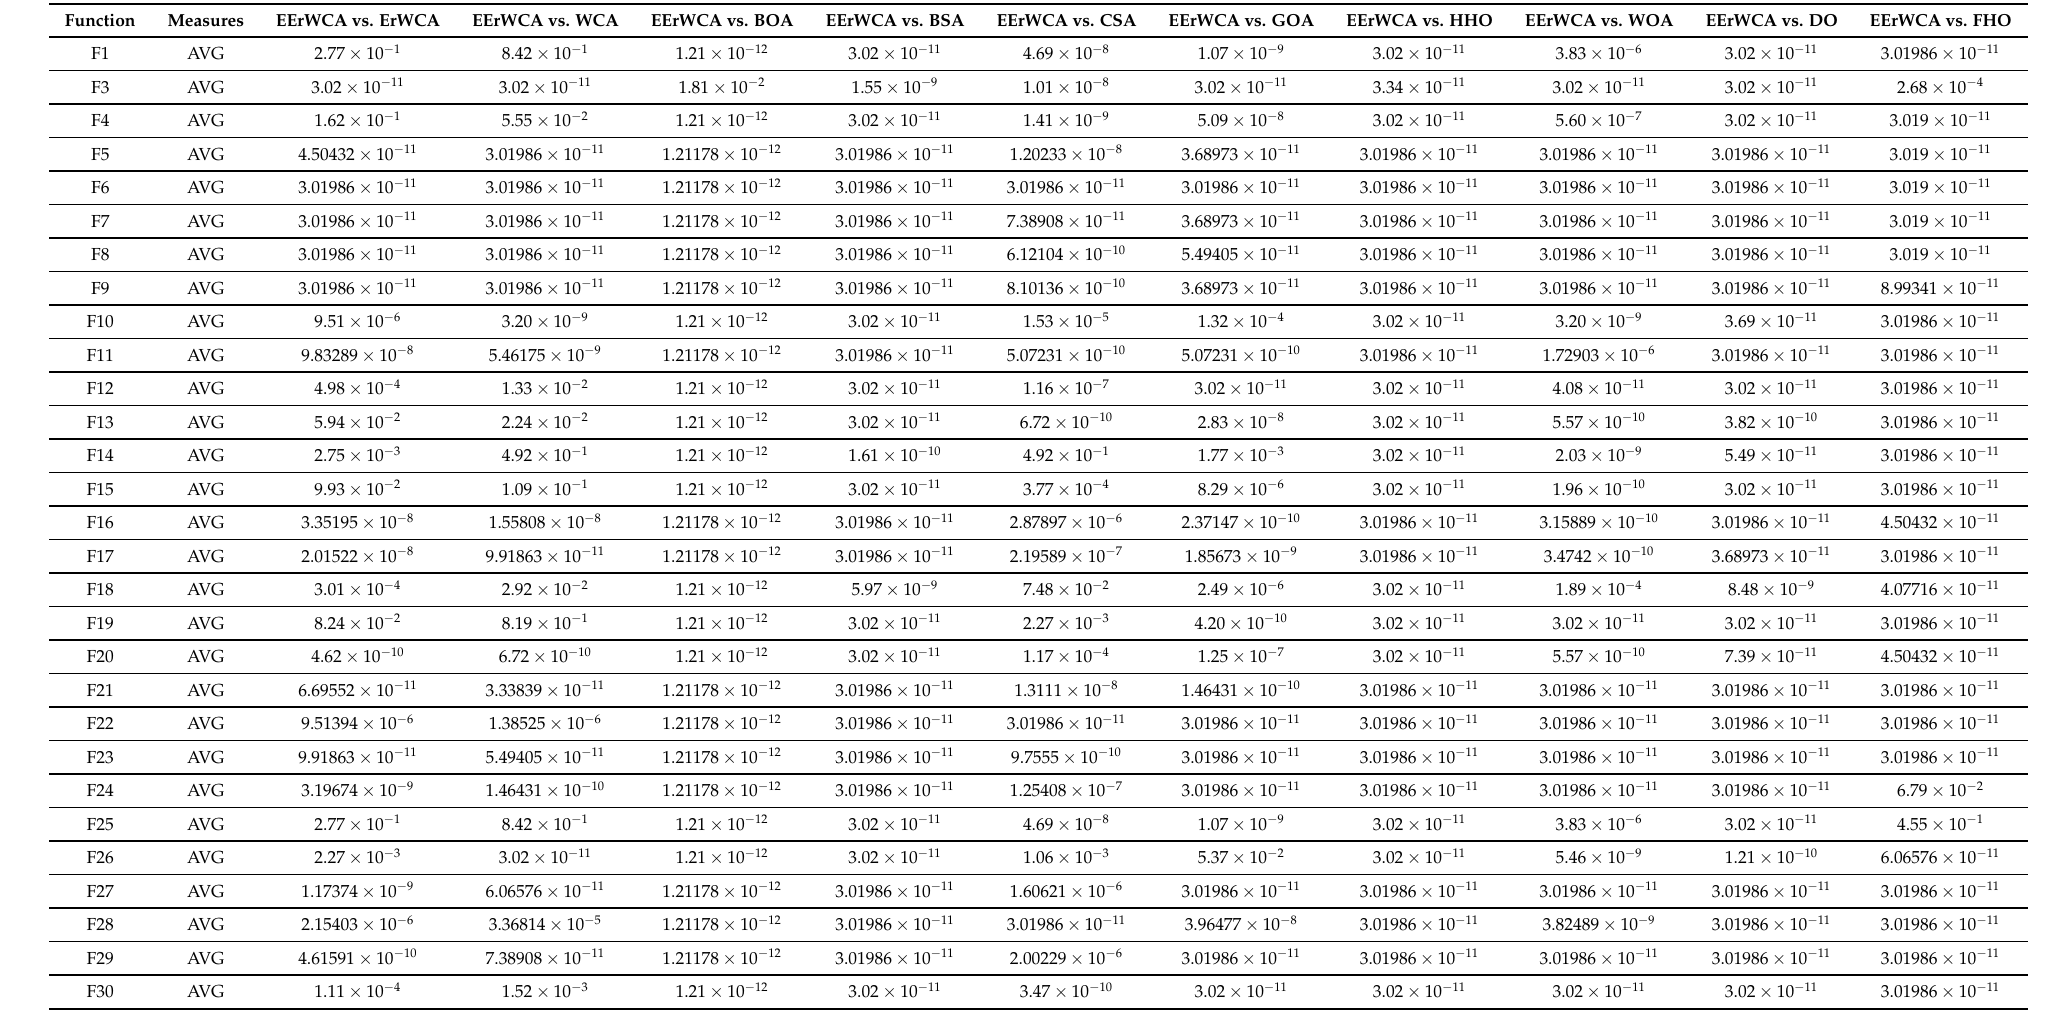
Table 4. The Wilcoxon signed-rank test for the comparative algorithms against the proposed EErWCA using CEC2017 benchmark functions, where a = 0.05 and dim =